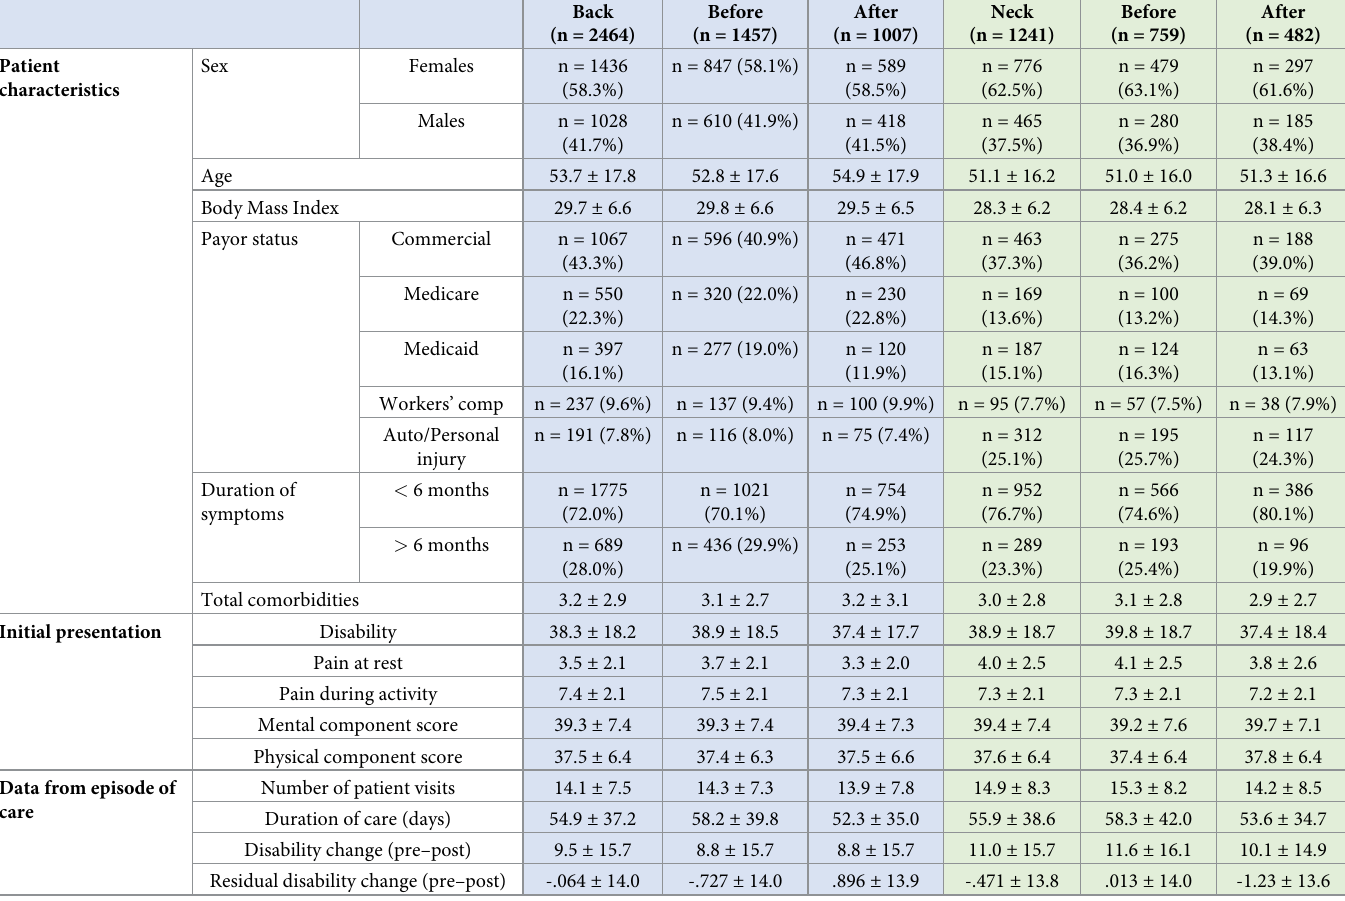
Table 1. Patient descriptive data of the 3,705 completed cases broken up into back or neck pain represented in means with standard deviations and proportions for categorical variables.